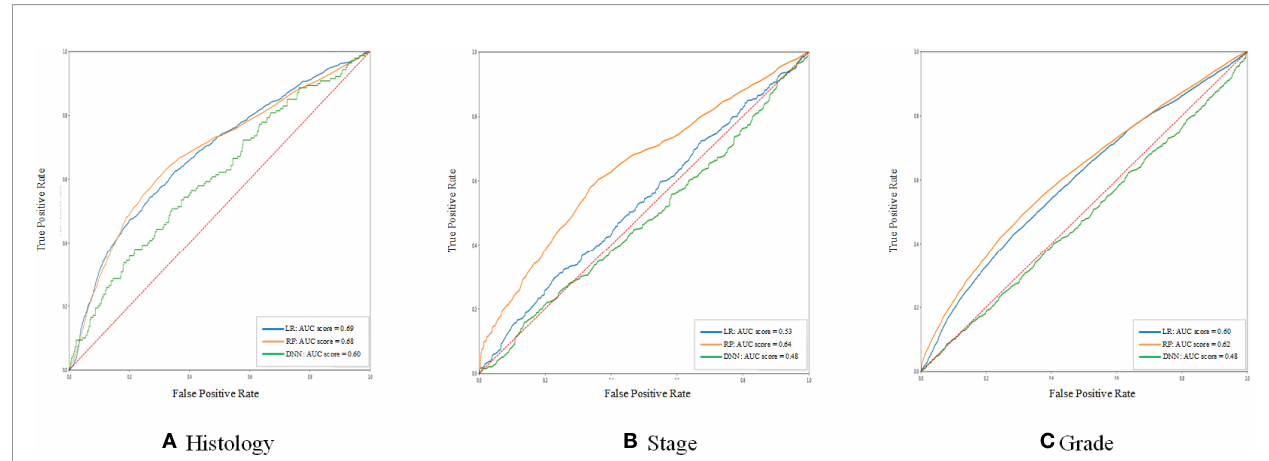
FIGURE 1 | The ROC curve of the histology stage and grade between different models. (A – C) shows the ROC curve and AUC score of three different models for histology, stage, and grade prediction,